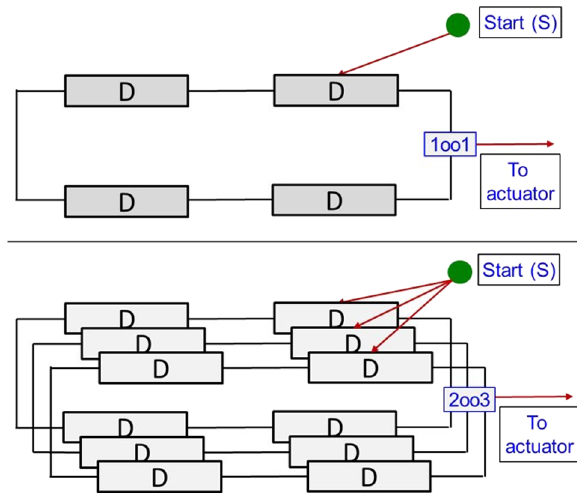
FIG. 10. Models for two architectures of interlock loops with four single detectors. The top part of the figure shows a single loop (1oo1). Any event that triggers a detector will lead to a protection shutdown. The bottom part shows three redundant loops and each single detector is replaced by three redundant detectors. In the example, an evaluation 2oo3 is shown. At least two out of three interlock loops are required to open following the event for a protection shutdown (2oo3). Other voting options are 1oo3 and 3oo3 for three redundant loops and 1oo2 or 2oo2 for two redundant